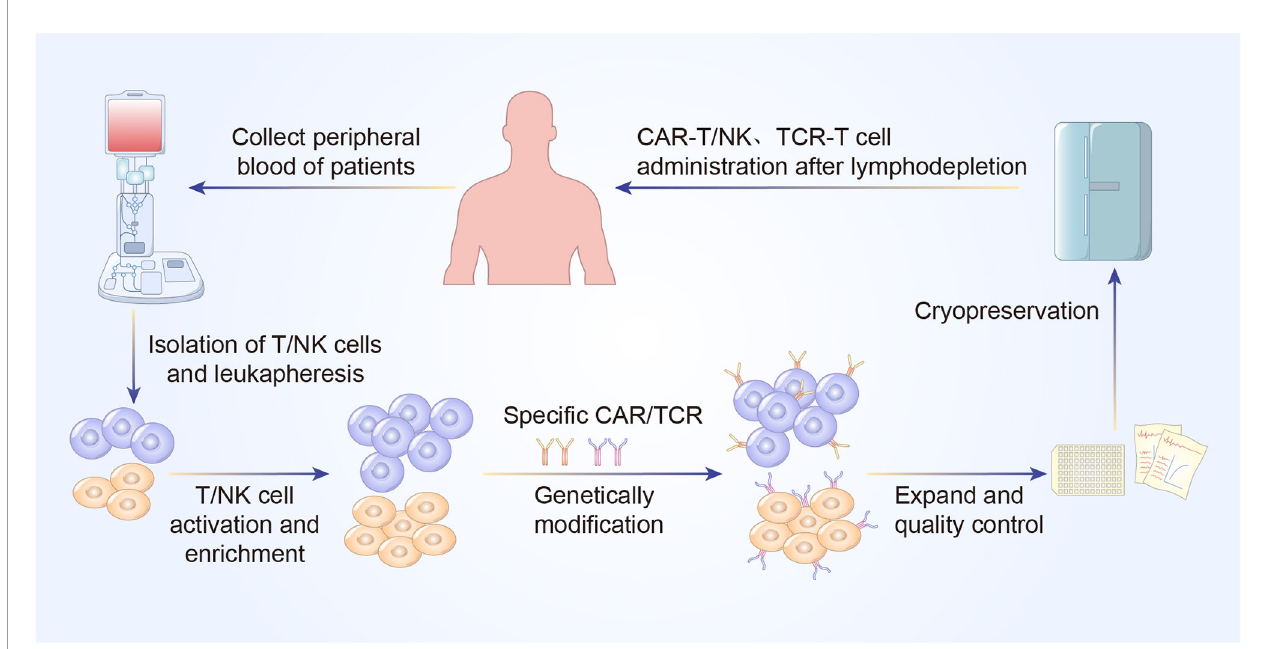
FIGURE 2 | A concise work fl ow of genetically modi fi ed T cell therapy in clinical practice. The peripheral blood is initially collected to isolated T/NK cells. The puri fi ed T/NK cells are activated and ampli fi ed ex vivo and genetically modi fi ed to express speci fi c CAR or TCR. Following expansion and quality control ex vivo, CAR-T/NK cells or TCR-T cells are infused back into the patients ’ body to eliminate cancer